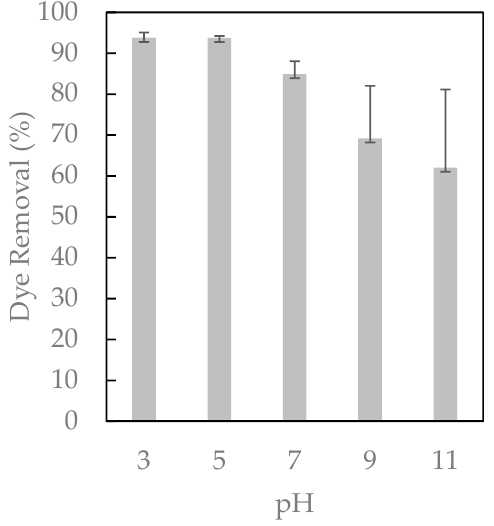
Figure 8. The effect of pH in the removal of Direct Red 83:1.